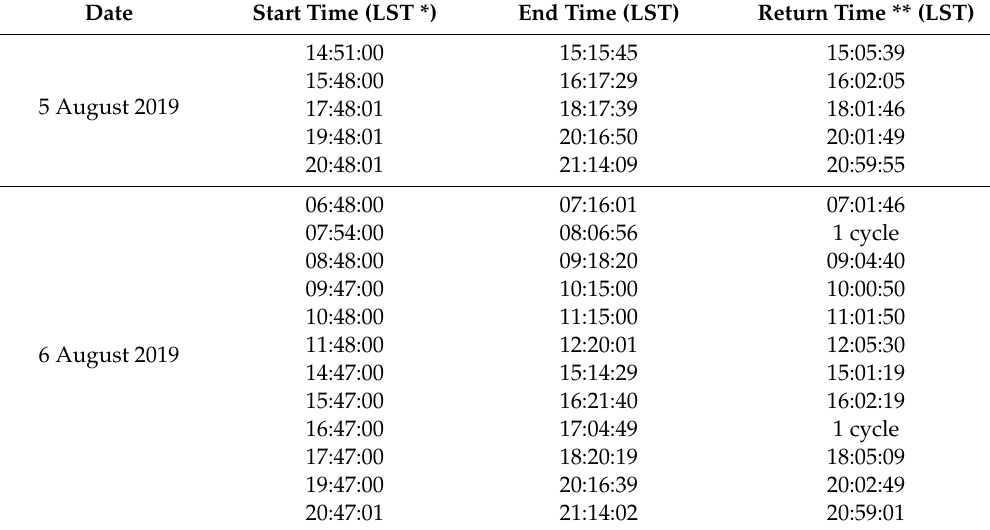
Table 3. Summary of observation times during the BBMEX